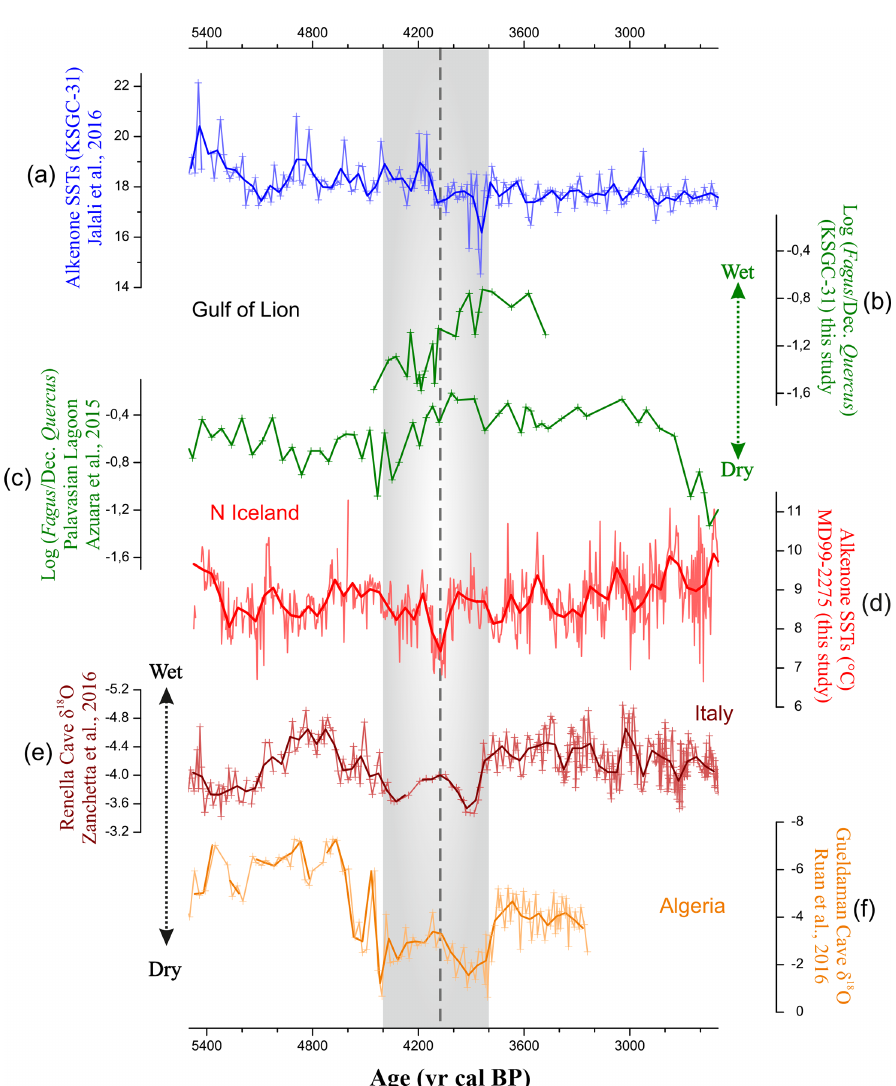
Figure 4. Expression of the 4.2kaBP event in the W Mediterranean region as recorded by marine and continental archives. (a) Alkenone SSTs at the KSGC-31 core in the Gulf of Lion (site 10, Fig. 1; Jalali et al., 2016). (b) Log Fagus / deciduous Quercus in the KSGC-31 core (this study). (c) Log Fagus / deciduous Quercus in core PB06 from the Palavasian Lagoon (site 11, Fig. 1; Azuara et al., 2015). (d) Alkenone SSTs at the MD99-2275 core (site 2, Fig. 1) (north Iceland; this study). (e) δ 18 O record obtained from Renella Cave stalagmite (site 12, Fig. 1) (north Italy; Zanchetta et al., 2016). (f) δ 18 O record obtained from Gueldaman Cave stalagmite (site 13, Fig. 1) (Algeria; Ruan et al., 2016). A 50-year binning is applied to reduce the effect of proxy reconstruction error (thick lines). The grey vertical band represents the 4.2kaBP event time interval